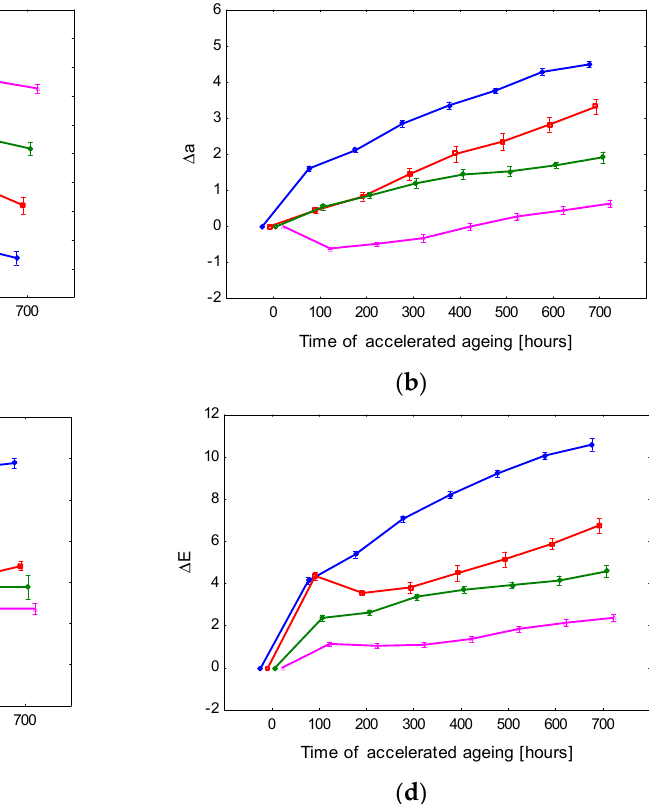
Figure 7. Accelerated-aging-induced differences in colour coordinates ( a ) Δ L* , (b ) Δ a* , and ( c ) Δ b* , and the total colour difference ( d ) Δ E* in spruce wood surfaces coated with water-based coating systems. Table 7. Basic statistical characteristics of colour coordinates L* , a* , and b* correspond to different phases of accelerated aging of oak wood surfaces treated with water-based coating systems. (The number of measurements in each set: n = 50.)